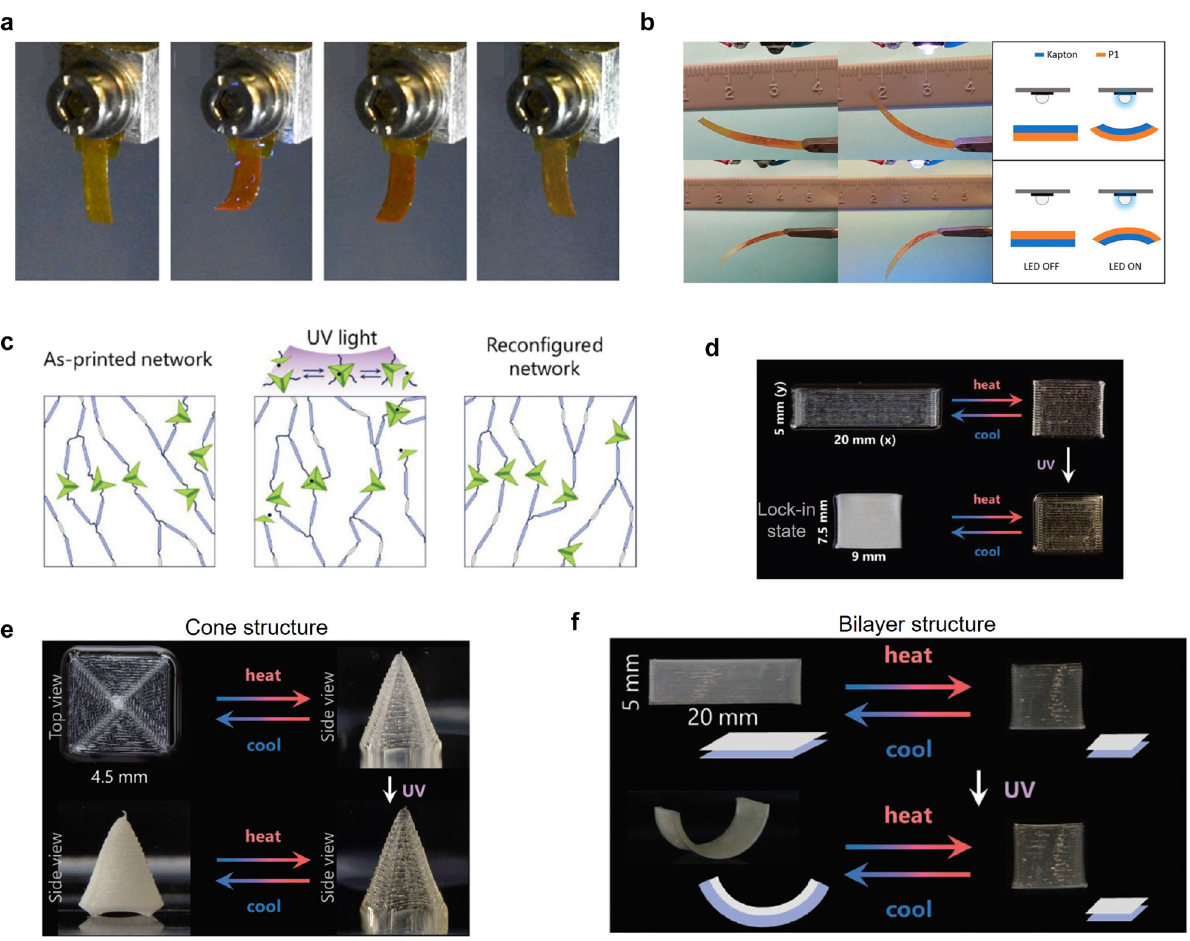
Figure 5: 3D printing of photochemical